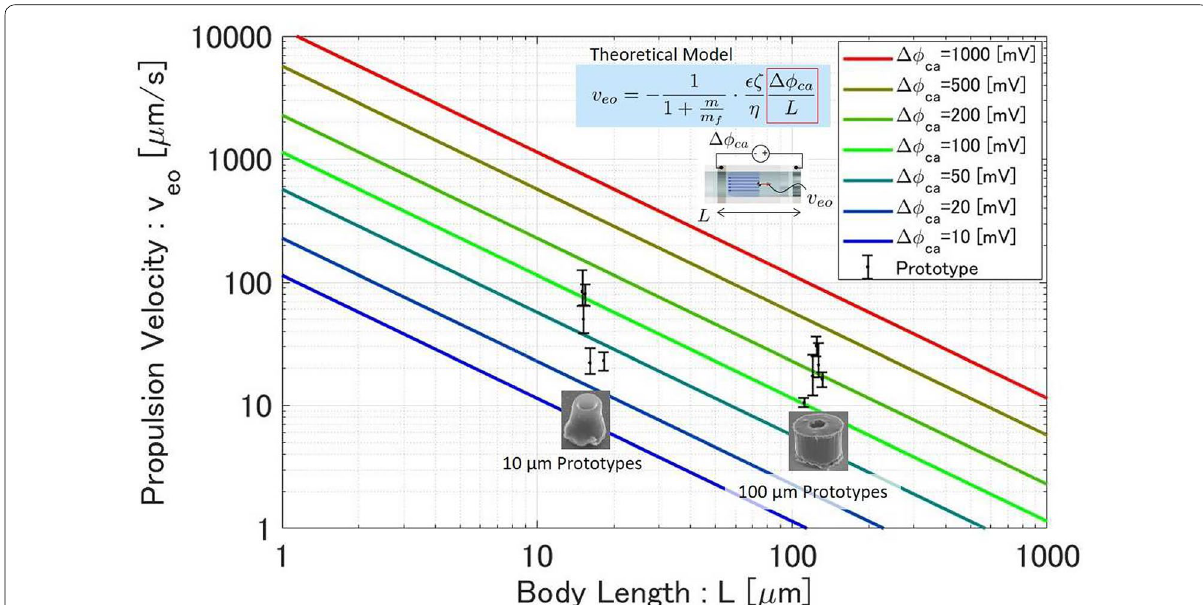
Fig. 4 Propulsion velocity against body length: theory and experiments. A point denotes a mean value of v eo experimentally identified and a bar denotes the range. The experimental data of 100 μm prototypes were referenced from